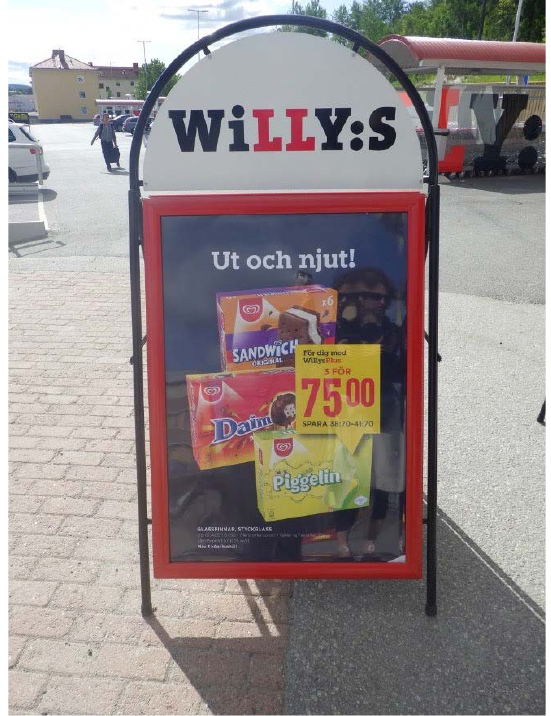
Figure 1. Commercial Sign on Sandwich Board.